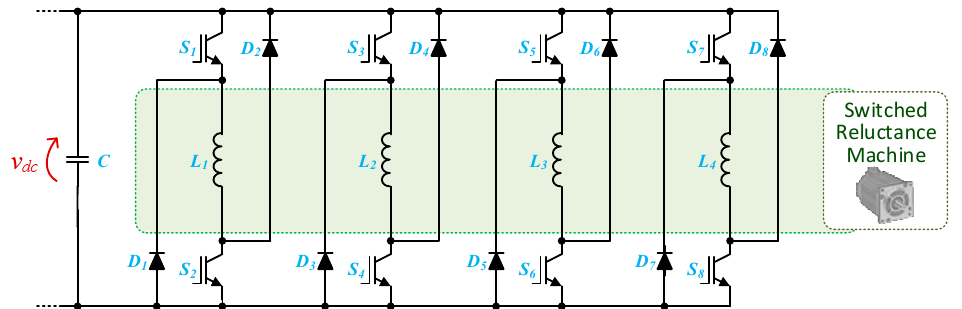
Figure 19. Classical power converter for switched reluctance machines. Energies 2020 , 13 , x FOR PEER REVIEW